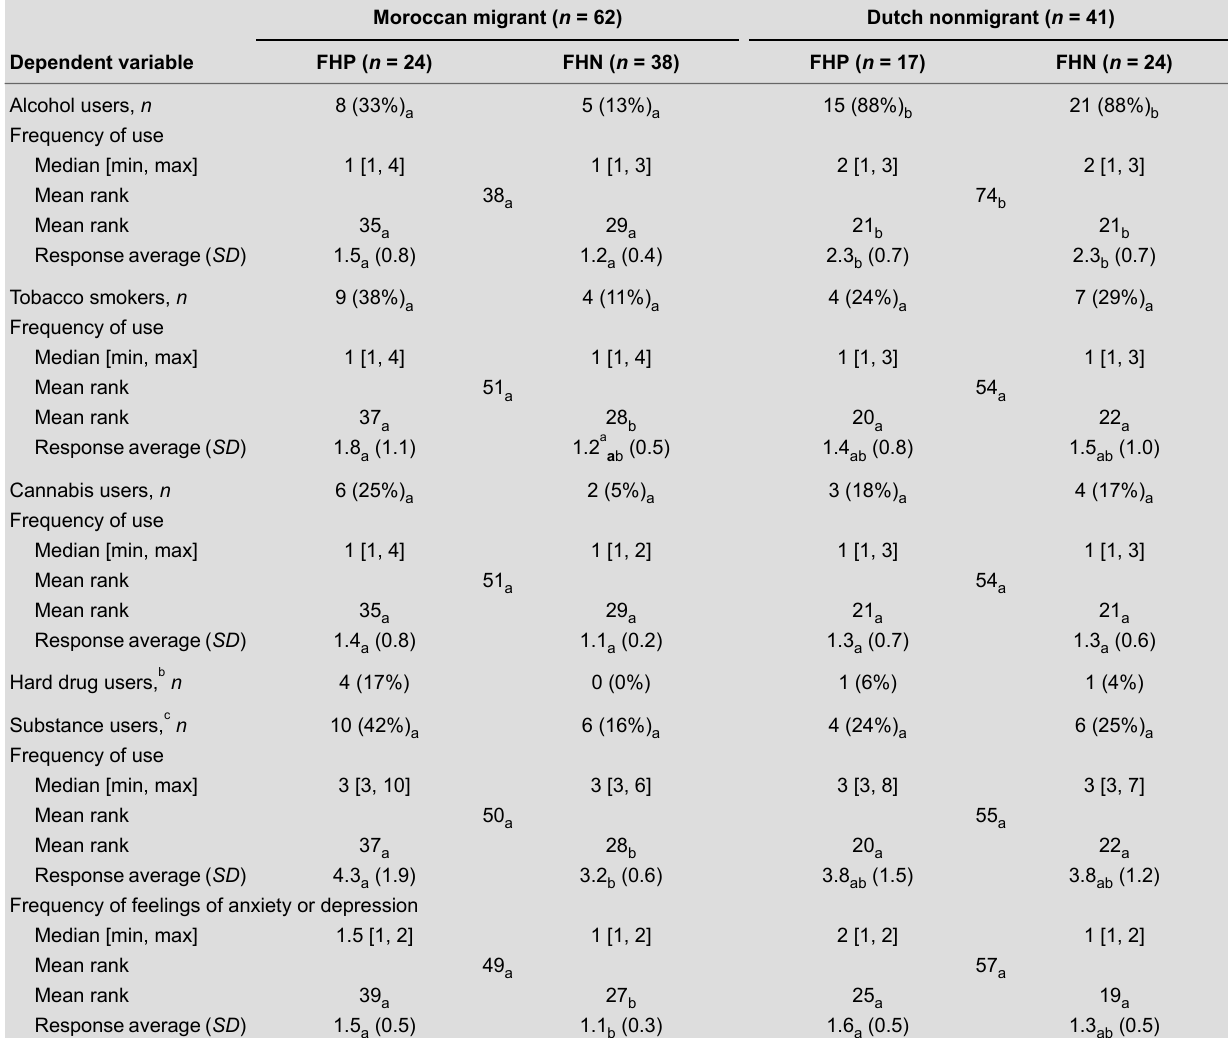
Substance Use and Feelings of Anxiety or Depression as a Function of Migration Status and Family History (N =